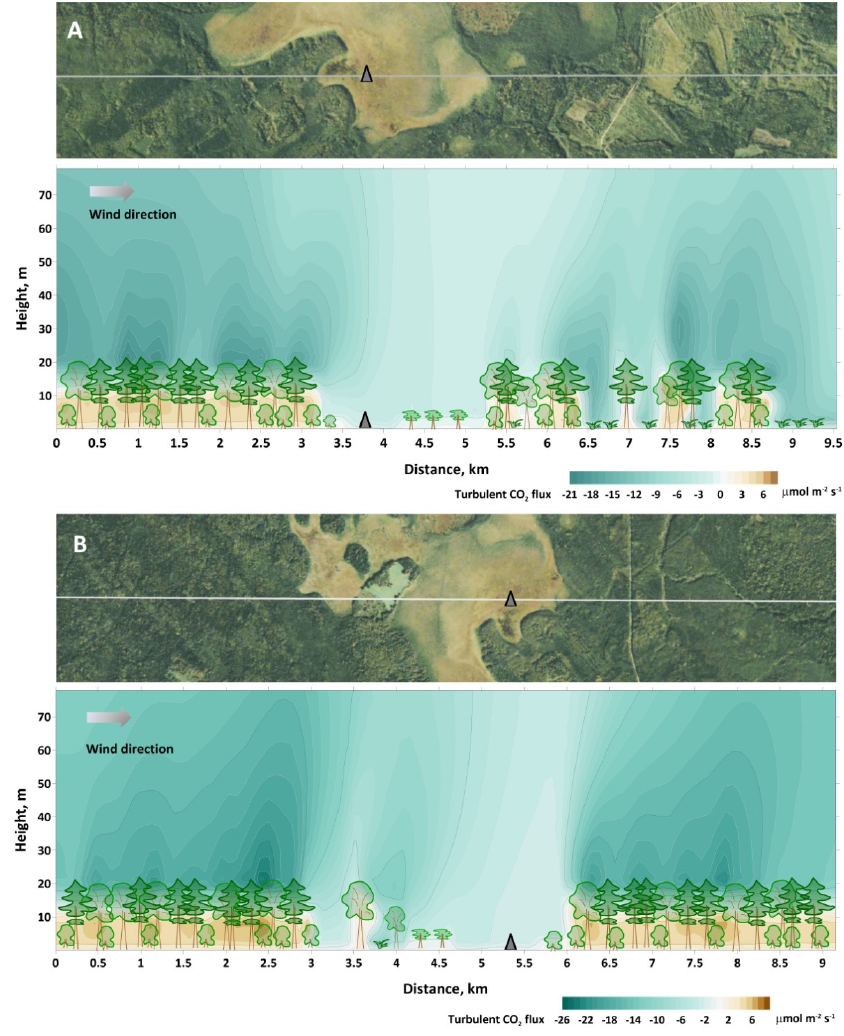
Figure 10. Top views and modeled cross-sections of vertical CO 2 fluxes along the two directions that cross the peatland and pass through the flux measurement site: ( A ) 25 June 2016 at 14:00, ( B ) 28 June 2016 at 13:30. The grey triangle indicates the location of the eddy covariance flux station. White lines in the top views indicate the locations of the